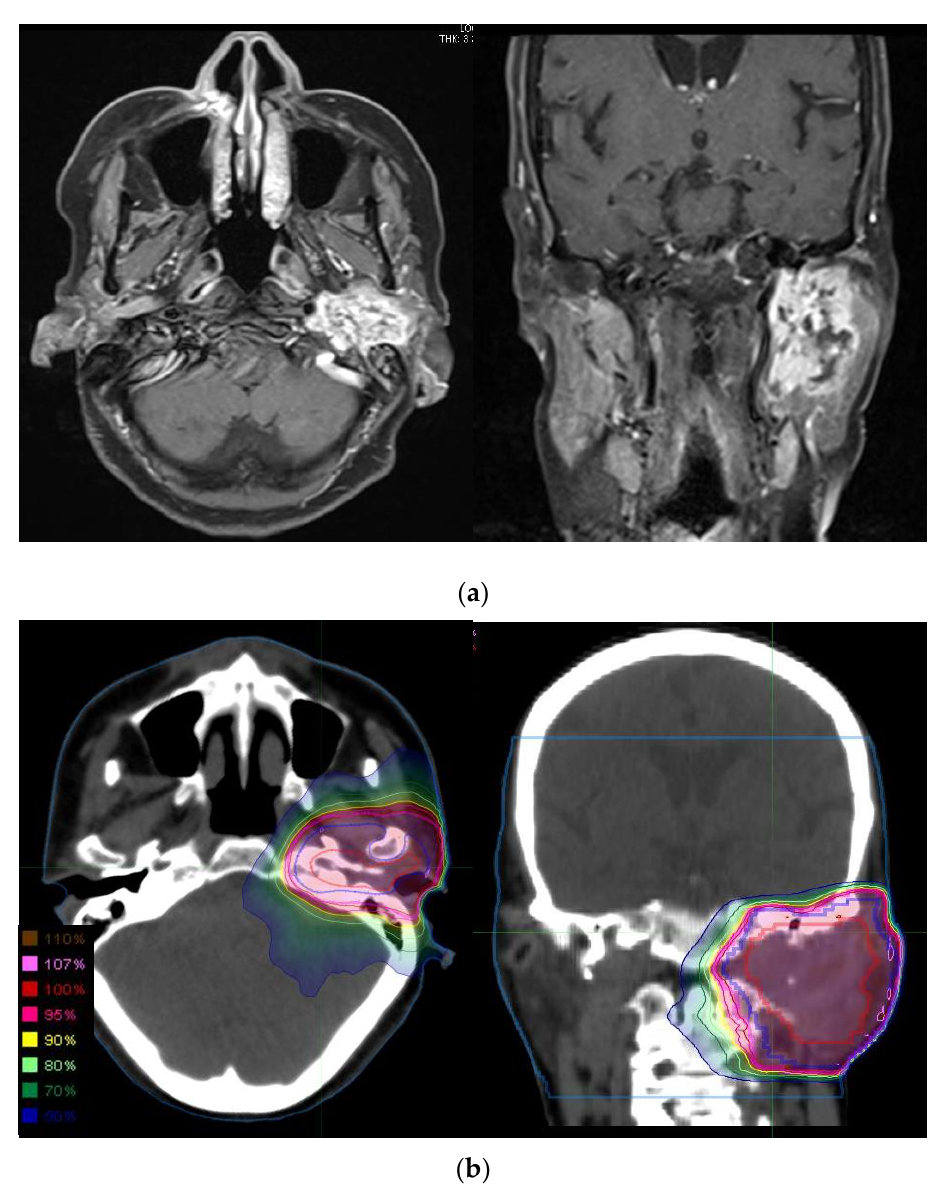
Figure 1. Representative case of parotid gland adenoid cystic carcinoma treated with defRT using IMRT. The 75-year-old woman with left parotid gland cancer, cT4bN0M0. Left facial nerve disorder was observed. ( a ) MRI contrast-enhanced T1-weighted images revealed the parotid gland tumor with the extension to base of skull. The patient refused surgery and hoped to receive defRT. ( b ) Dose distribution of defRT using 66 Gy in 33 fractions. The GTV, CTV, and PTV are shown in red, blue, and magenta, respectively. CTV margin was extended to base of the skull considering perineural invasion. PTV margin was added to CTV to account for patient motion and the field margins. Abbreviations: defRT, definitive radiotherapy; IMRT, intensity-modulated radiotherapy; MRI, magnetic resonance imaging; GTV, gross tumor volume; CTV, clinical target volume; and PTV, planning target